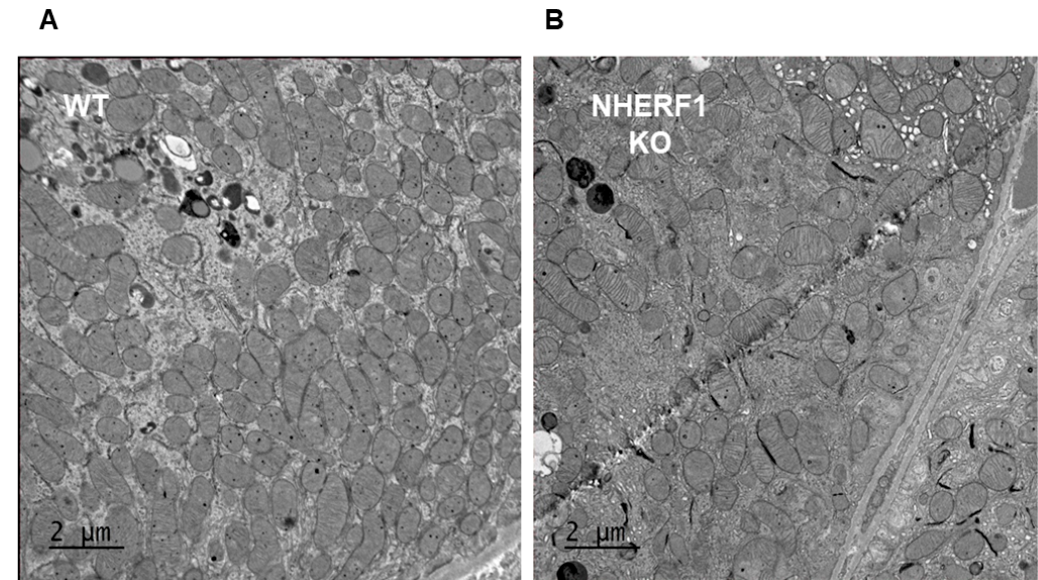
Representative photomicrographs show a 4x field of WT and NHERF1 KO proximal tubule mitochondria. Panel A represents the proximal tubule mitochondria of WT mice, while panel B represents NHERF1 KO proximal tubule mitochondria (WT n = 6) and (NHERF1 KO n = 5). The scale bars were set at 2 μ m.